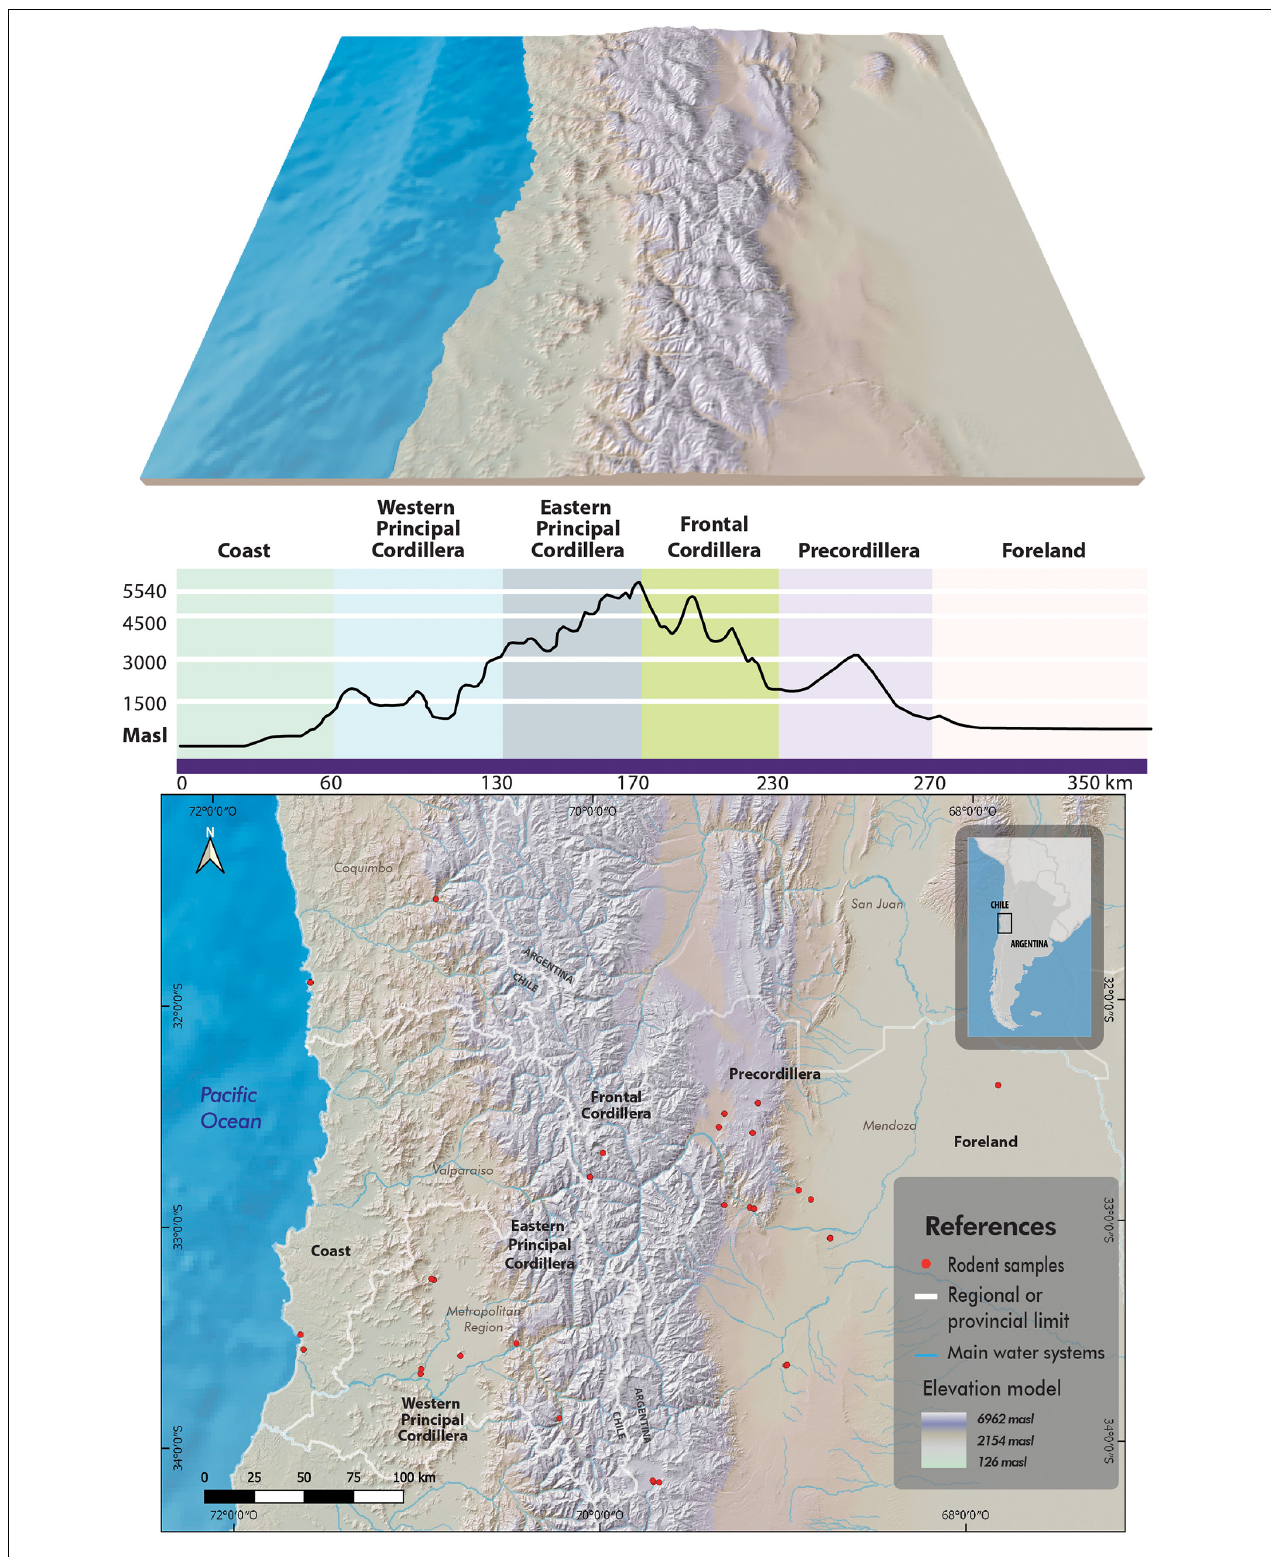
FIGURE 1 | Study area and location of the samples for isotopic analysis.